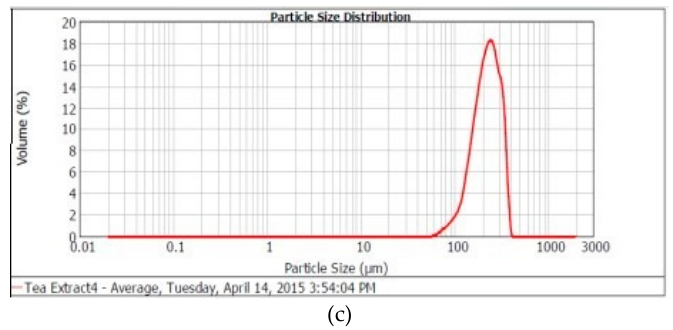
Figure1. Particle size distribution curve of spray dried Microparticles ( a ) Placebo peak; ( b ) maltoxtrin- gum arabic peak ( c ) maltodextrin:gum arabic:chitosan loaded